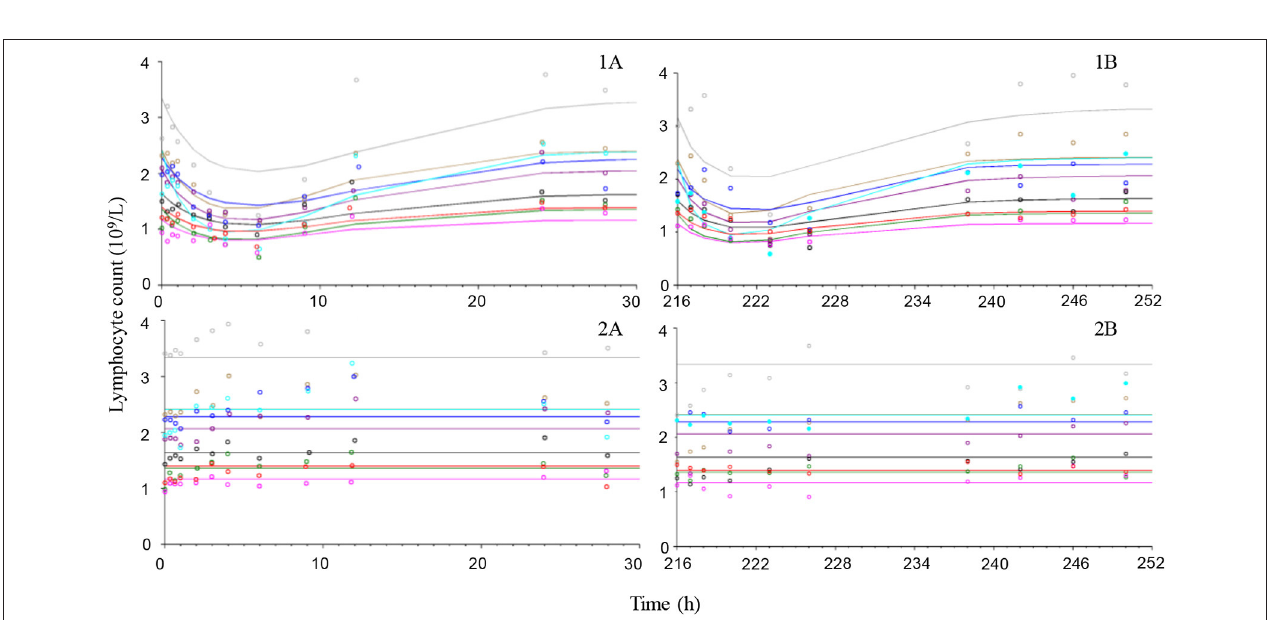
FIGURE 4 | Observed (symbols) and model predicted (lines) neutrophil count-time courses following intravenous administration (left plots) of 1 mg/kg prednisolone succinate (1A) or saline (2A) and after the last oral (right plots) dose (216h after first dose) of ∼ 1 mg/kg for 10 consecutive daily doses orally (1B) or placebo (2B) to 9 beagle dogs.